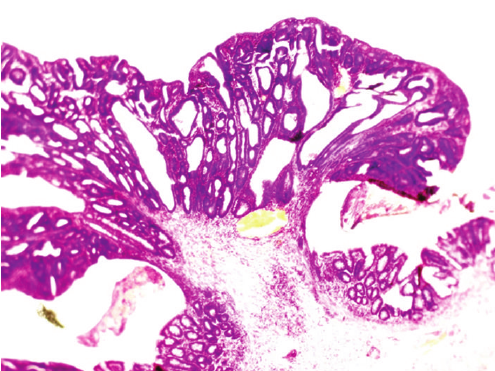
Figure 3: Flat dysplasia seen in colonic mucosa from a rat in the DSS group.